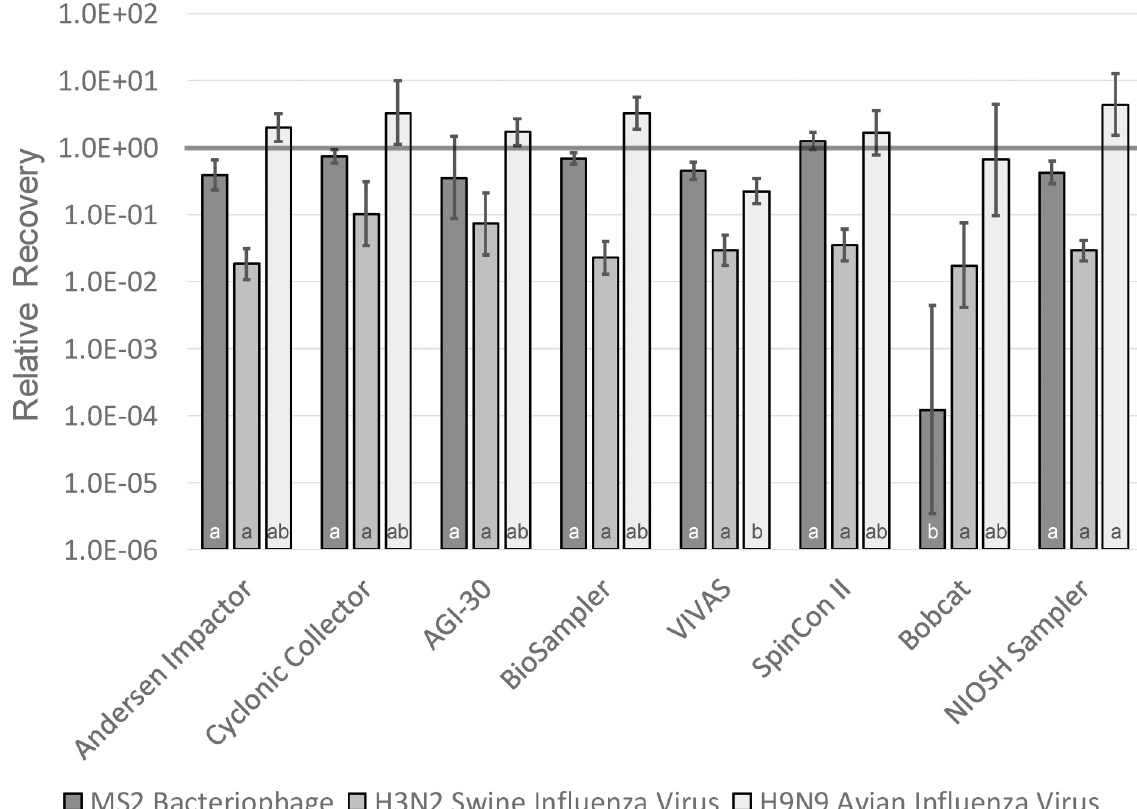
Fig 4. Relative recovery measured for MS2 bacteriophage, H3N2 swine influenza virus, and H9N9 avian influenza virus for each of the air samplers. Bars represent geometric means and error bars represent ± one geometric standard deviation. Same letters indicate geometric means that are not significantly different from one another within each type of